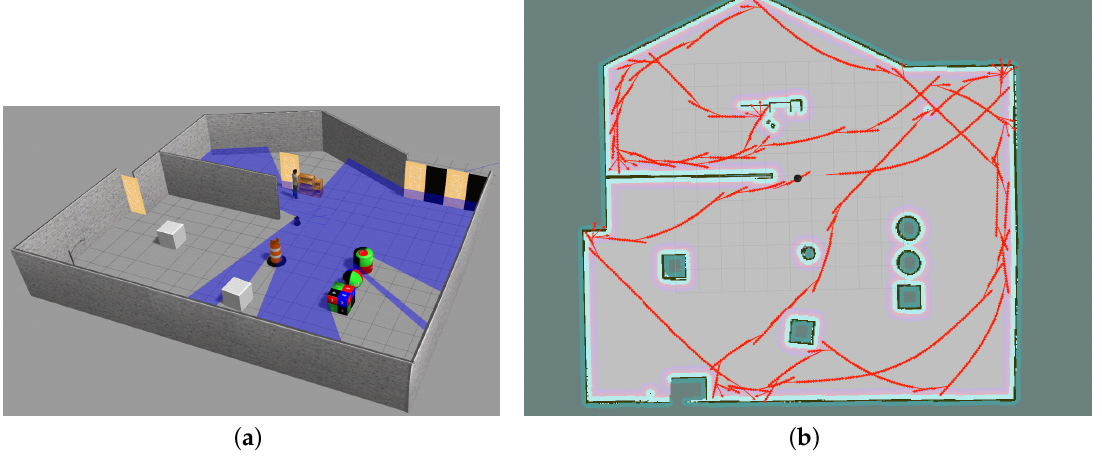
Figure 10. Simulation in a new unknown environment. ( a ) A complex unknown environment simulated in Gazebo; ( b ) SLAM visualization of robot movement in a new unknown complex